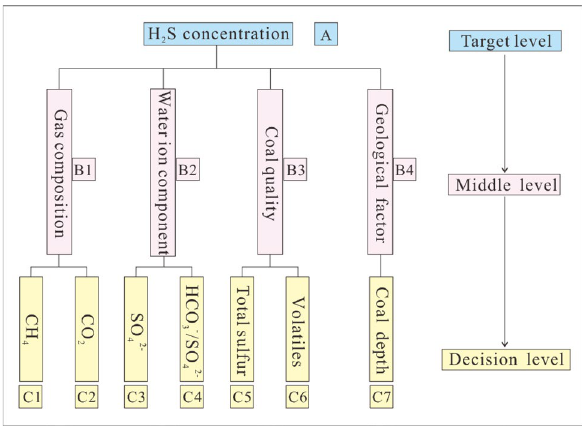
Figure 9. Schematic diagram of the AHP structure model.